Question: Write a caption explaining this figure to a reader.
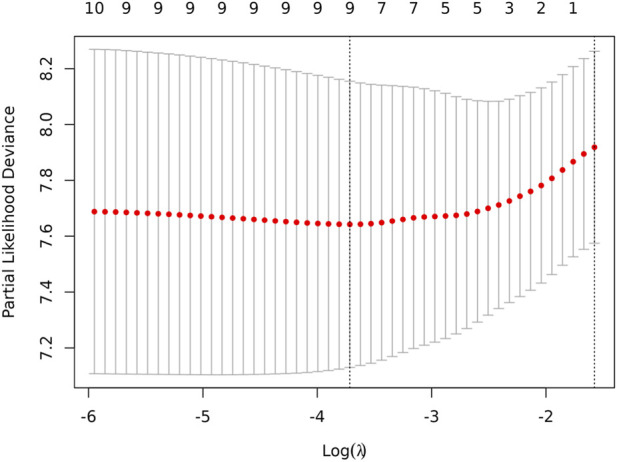
Answer: Tuning parameter (λ) selection cross-validation error curve (λ = 0.0243341096455763).